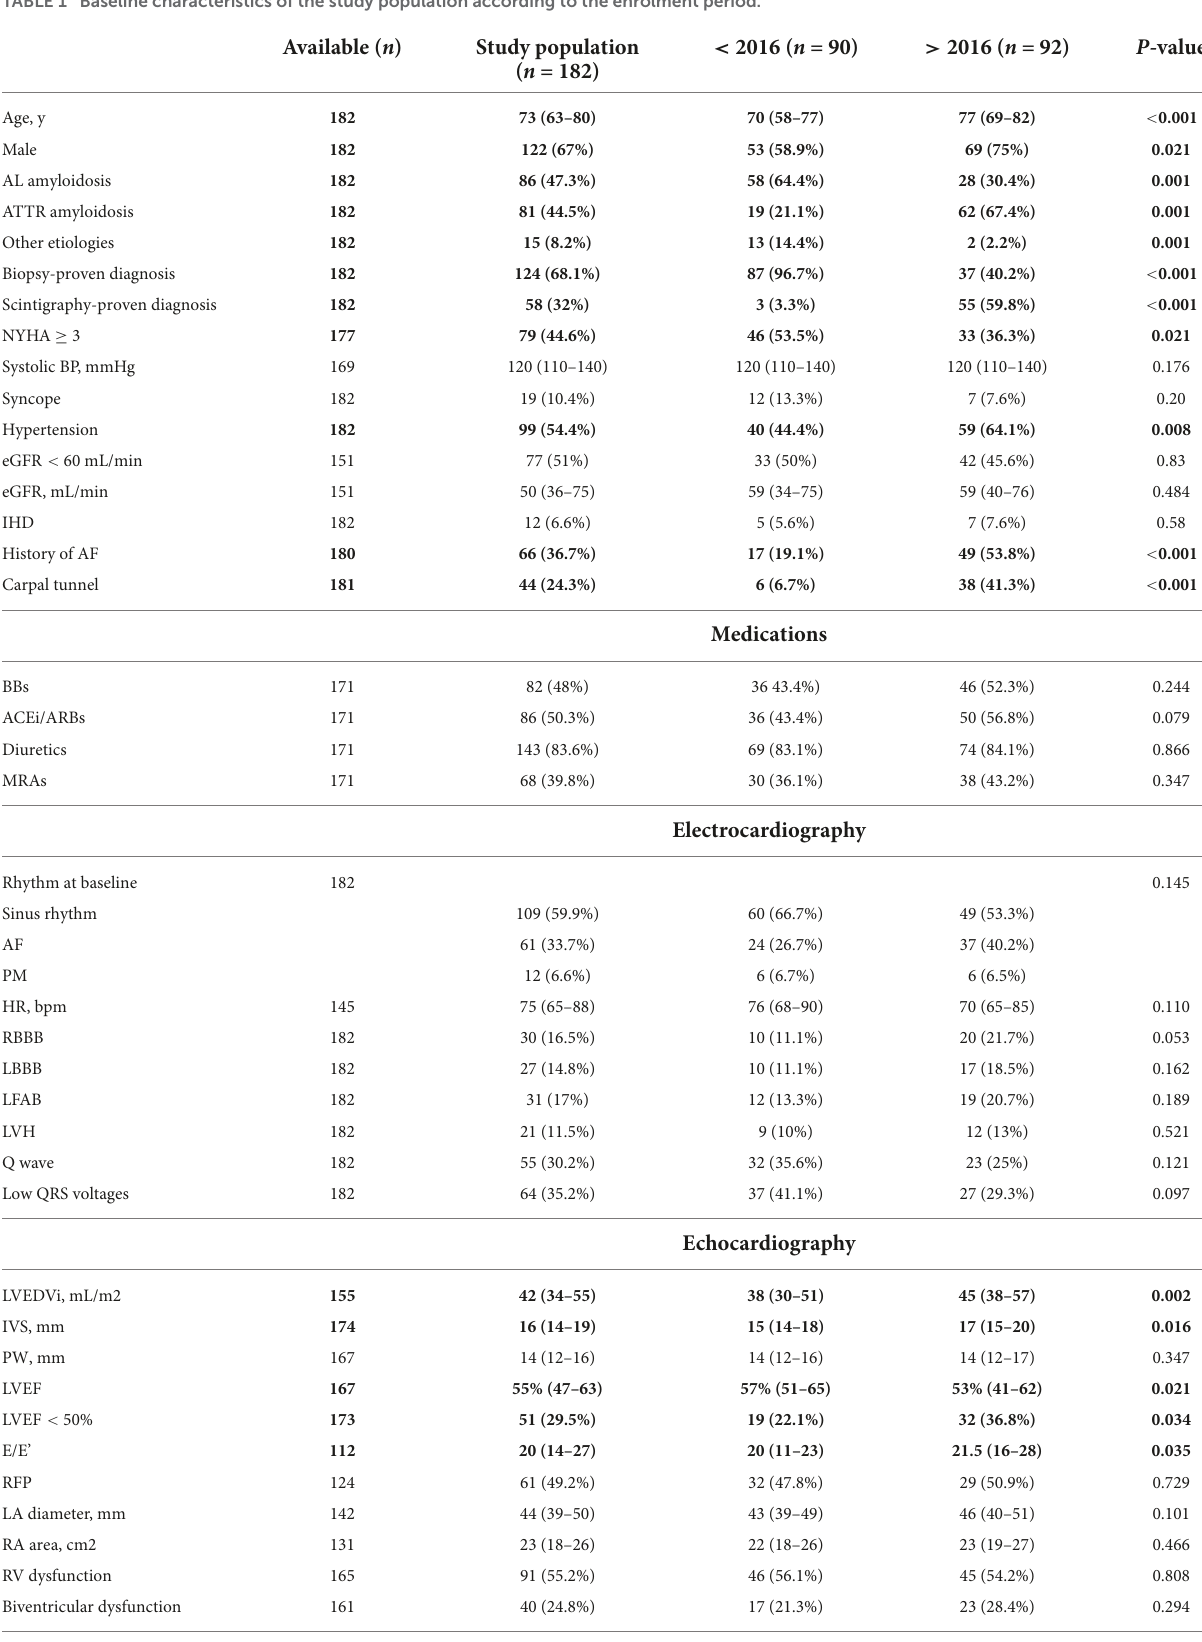
TABLE 1 Baseline characteristics of the study population according to the enrolment